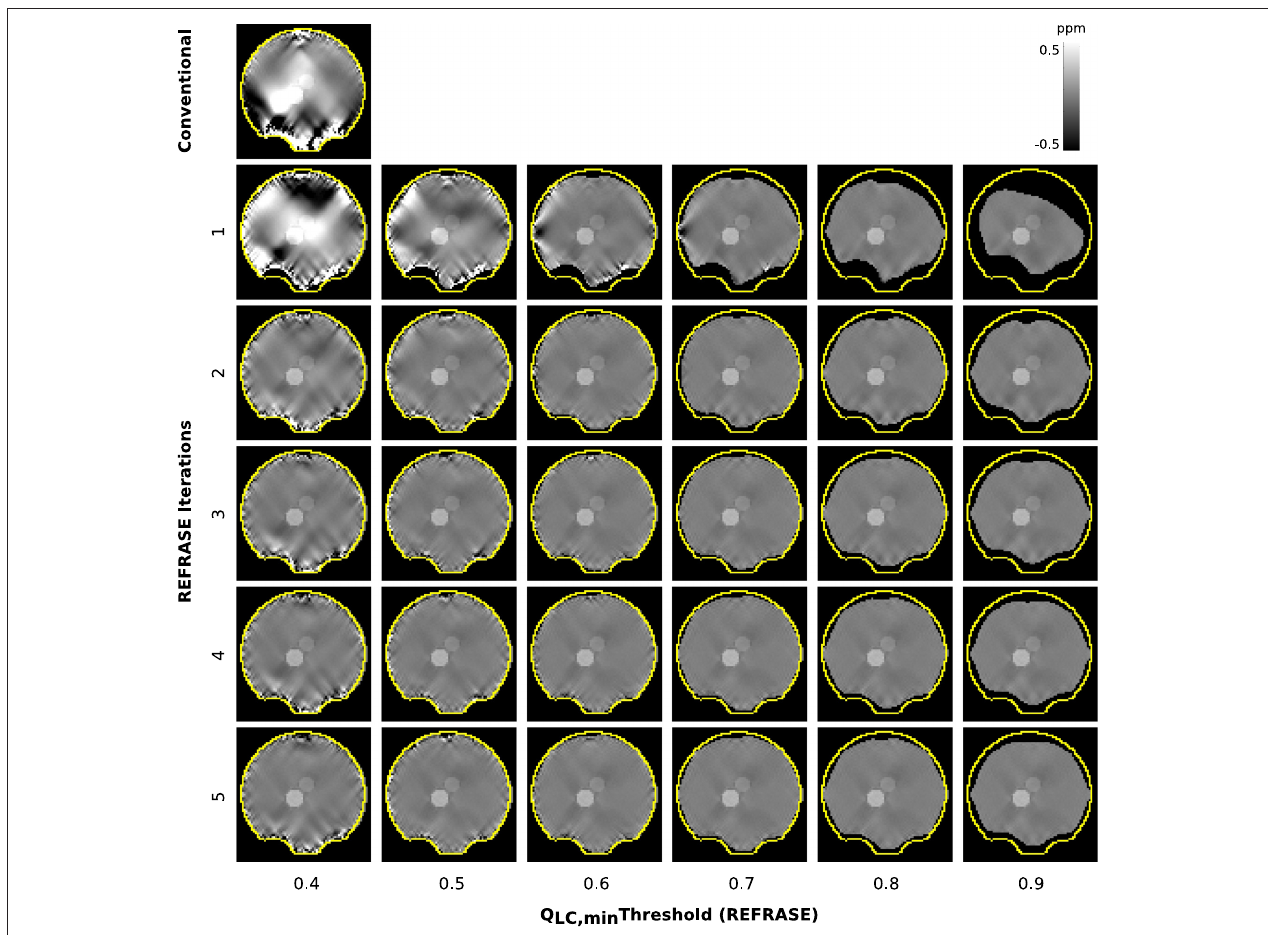
FIGURE 5 | Overview of the susceptibility maps obtained in the simulation showing one coronal sample slice for each iteration (vertical) and each threshold configuration (horizontal). The top left image shows conventional reconstruction without REFRASE. Black background indicates the mask support of each illustrated image, while the yellow line indicates m max